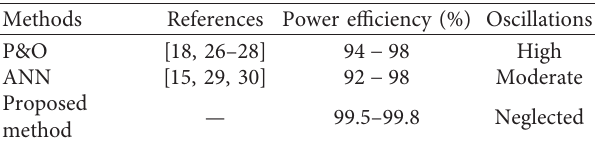
Table 5: Comparison between the P&O algorithm, ANN, and the proposed method.